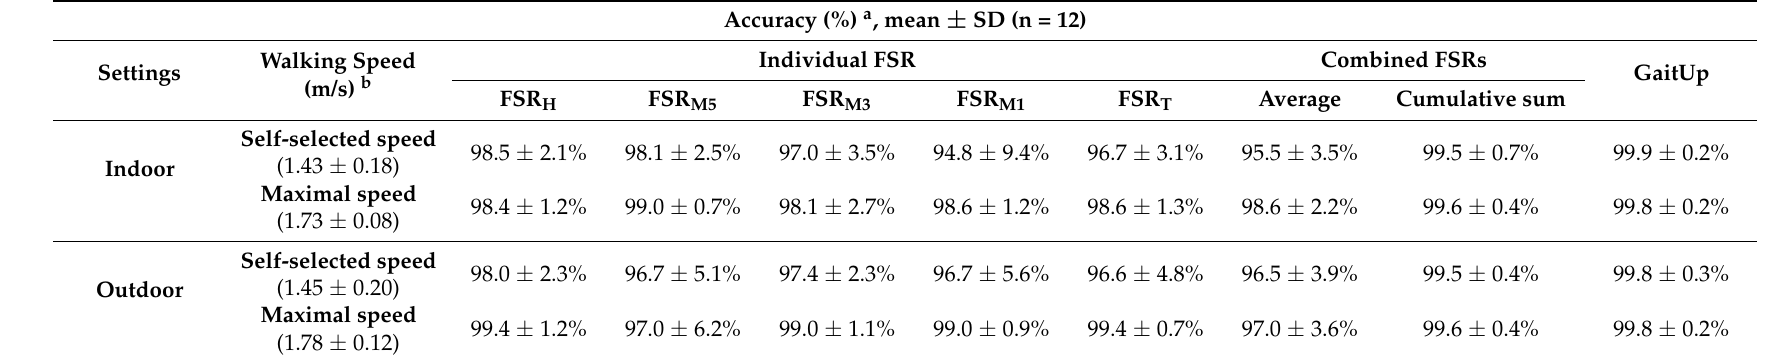
Table 3. Accuracies for step count using instrumented insole, compared with Gait Up and manual